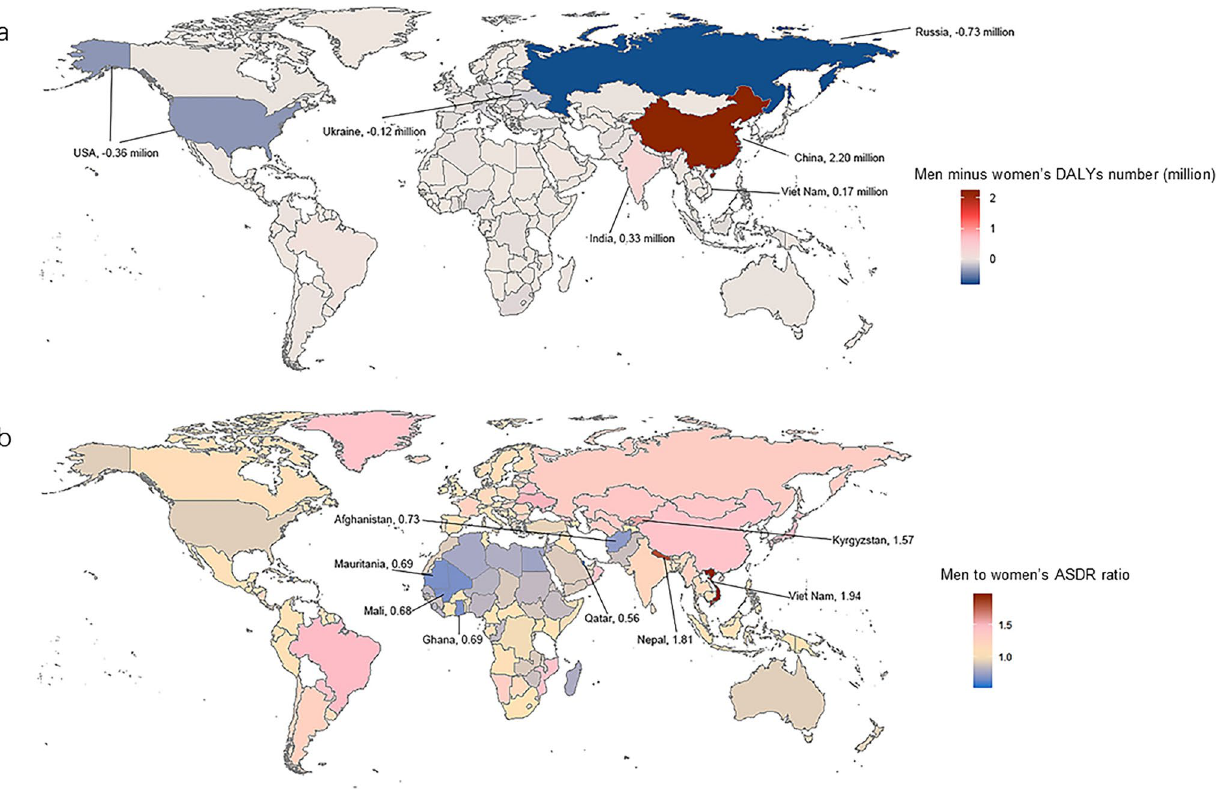
Figure 4. Global sex difference in DALYs number (men minus women) ( a ) and ASDR ratio (men to women) ( b ) due to ischemic stroke in 2019. Abbreviations: DALYs, disability-adjusted life years; ASDR, age-standardized DALYs